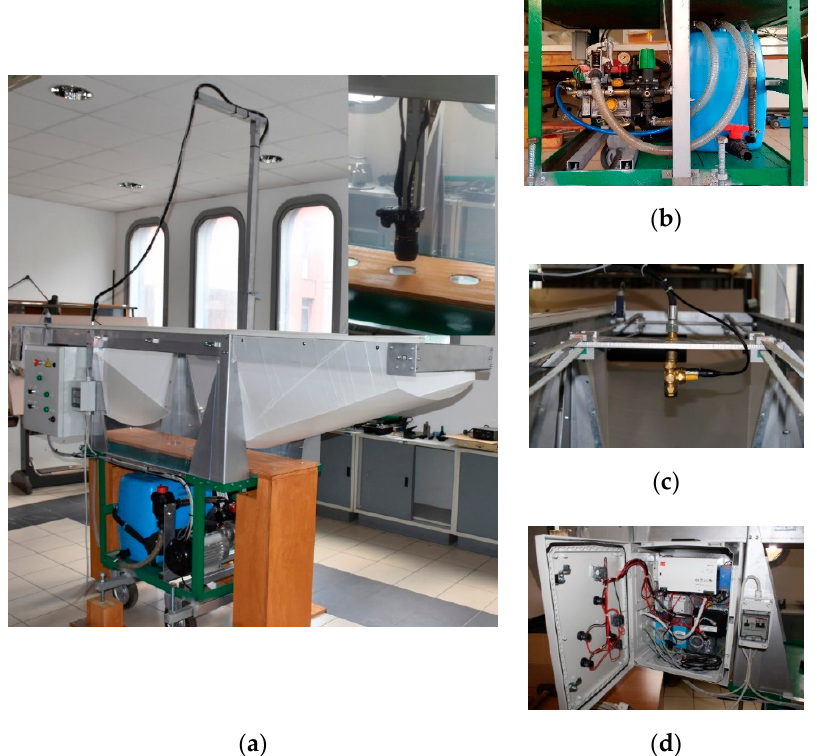
Figure 7. Main components of the test bench: ( a ) the whole system with the digital single-lens reflex (DSLR) camera and the wood table; ( b ) the main tank with the electric motor pump and the pressure regulators; ( c ) the mobile platform with the nozzle holder and the sensor pressure; ( d ) the cabinet with the electric components.